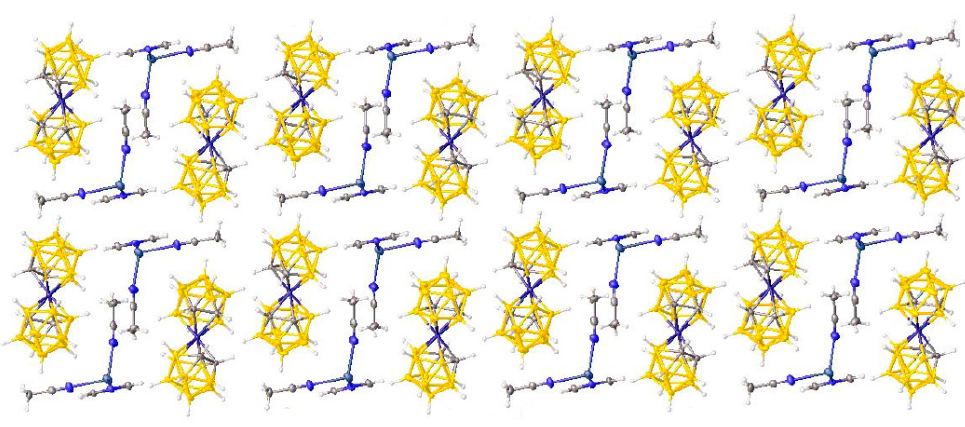
Figure 108. Crystal packing in the structure of {(Ag(pyz)(MeCN) 2 )[3,3’-Co(1,2-C 2 B 9 H 11 ) 2 ]} n . Two polymorphs of complex {(Ag(4,4’-Bipy)(MeCN))[3,3’-Co(1,2-C 2 B 9 H 11 ) 2 ]} n was prepared by crystallization of Ag[3,3’-Co(1,2-C 2 B 9 H 11 ) 2 ] with 4,4’-bipyridine in acetonitrile [106]. The silver coordination environment is essentially the same for both polymorphic forms, with silver cation coordinated by an acetonitrile and by two 4,4’-bipyridine molecules in a T-shape arrangement. In